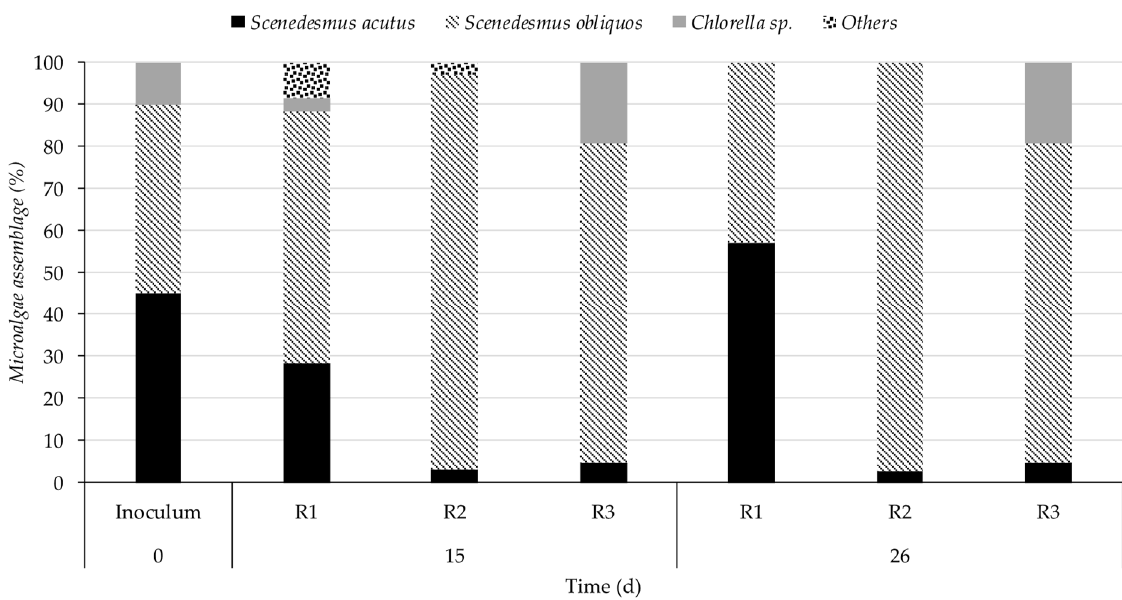
Figure 3. Variations of the microalgae population in the HRAPs (R1, R2, and R3) during the operational period. The microalgae population was monitored on day 0 (inoculum), day 15 (half of experiment), and day 26 (end of experiment).